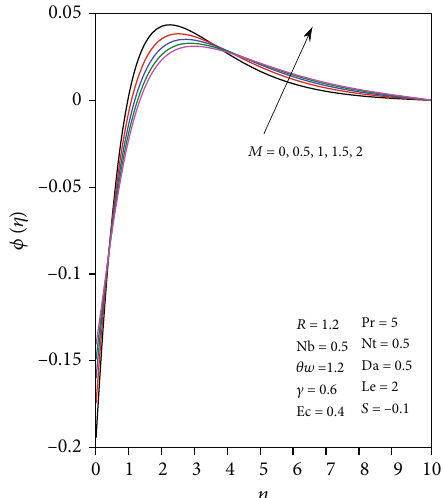
M = 0, 0.5, 1, 1.5, 2